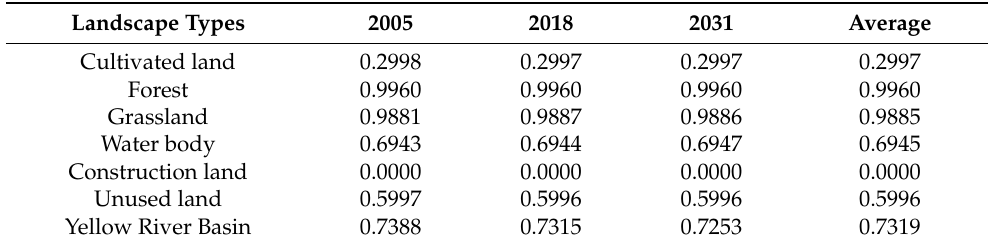
Table 5. Average habitat quality of landscape types in the Yellow River Basin from